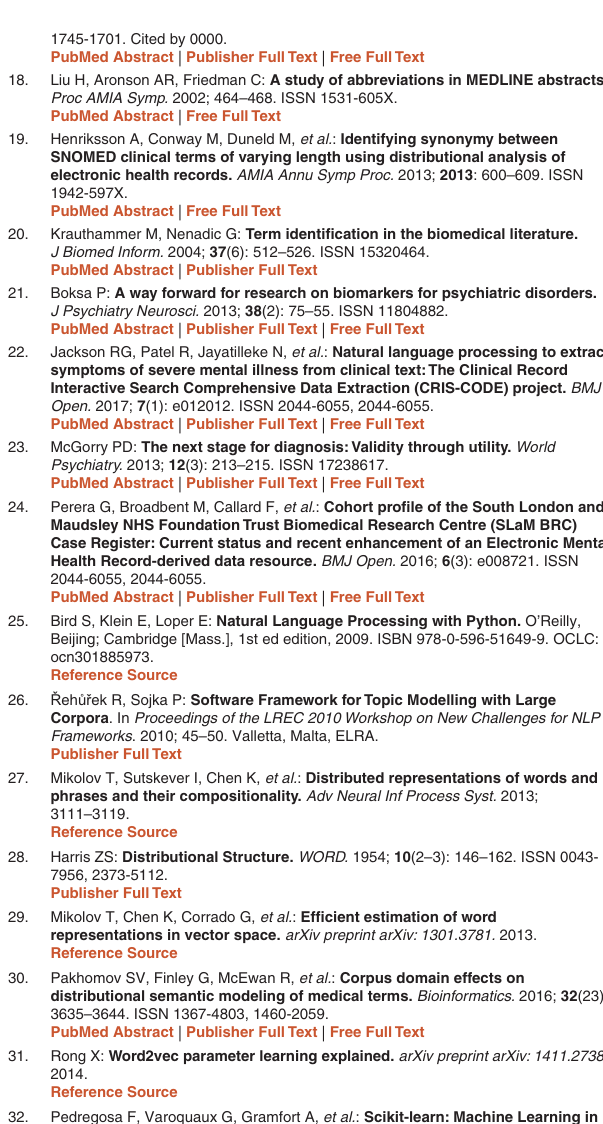
Supplementary Figure 1: This file is an expanded visualisation of the frequency analysis figure contained in the main manuscript, with the agreement and nonsubstantive ‘other’ classification restrictions lifted. Click here to access the